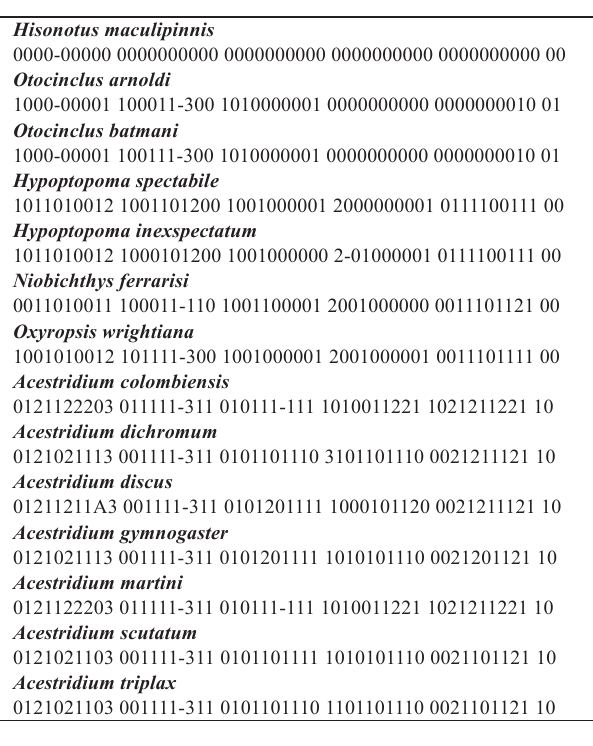
Table 1. Character state matrix used for the parsimony analysis. A = 0 and 1. Hyphen = missing data or inapplicable states.